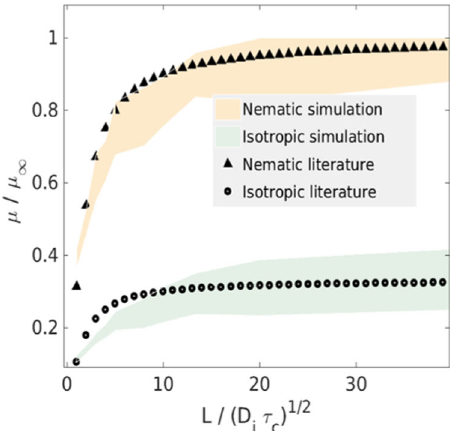
Fig. 2 Relative charge carrier mobility as a function of the length of the rod. The triangles represent the analytical solution for perfectly oriented rods and the circles represent isotropic orienta- tion; the colored bands represent the range of the values from the graph-based model. The mobility has been non-dimensionalized with the mobility of an in fi nitely long rod that is perfectly oriented along the conduction axis and the length was non-dimensionalized with the distance, ð D i τ c Þ 1 = 2 , a charge would diffuse on an in fi nitely long rod in a time τ c